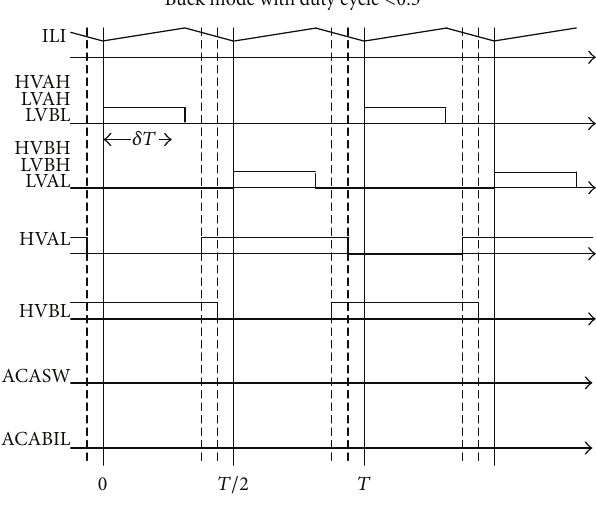
Figure 5: Buck mode modulation.